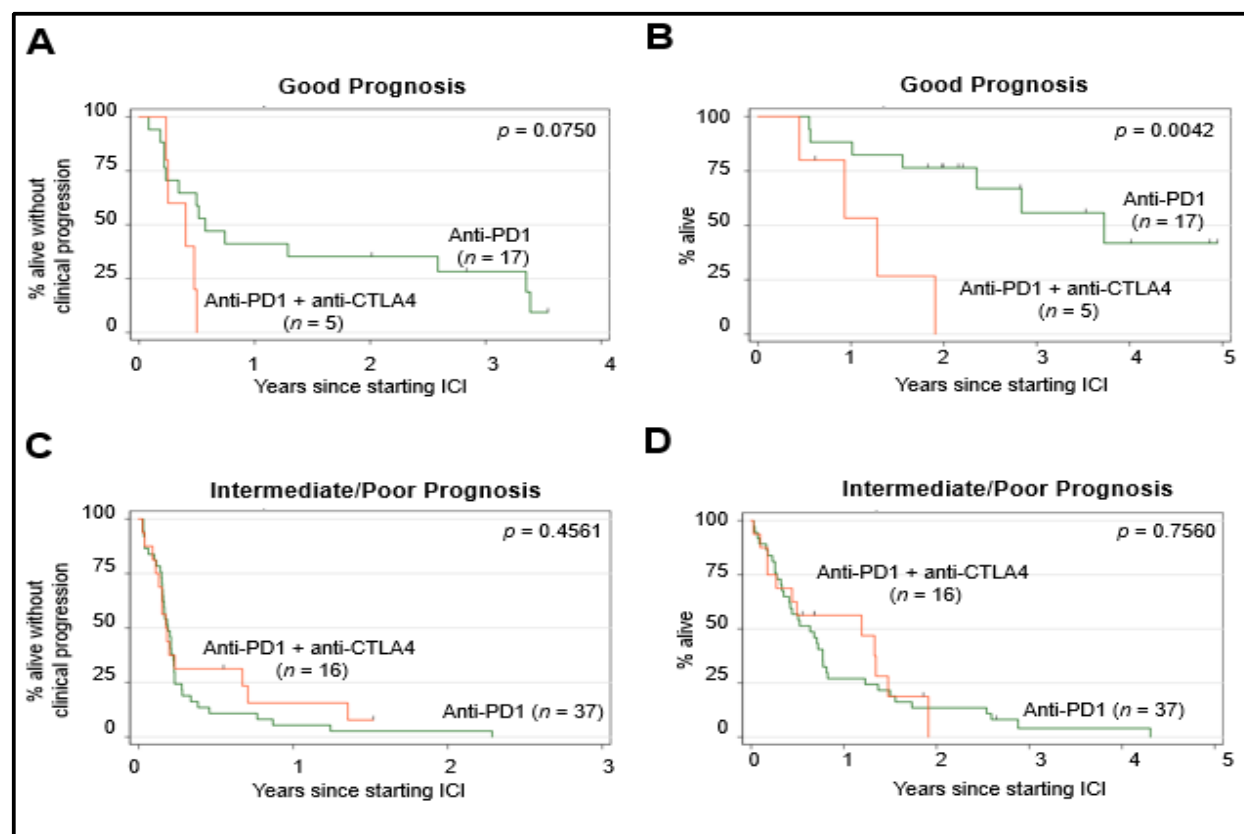
Figure 4. Survival according to MUMPS groups and ICI regimen. Survival outcomes of patients with good prognosis (MUMPS = 3) were stratified according to the anti-PD1/L1 regimen they received: anti-PD1/L1 monotherapy ( n = 17), anti-PD1 + anti-CTLA4 ( n = 5). cPFS is Scheme 0. (cPFS); p = 0.0042 (OS). Survival outcomes of patients with intermediate (MUMPS = 2) or poor prognosis (MUMPS = 0–1) were stratified according to the anti-PD1 regimen they received: anti- PD1/L1 monotherapy ( n = 37), anti-PD1 + anti-CTLA4 ( n = 16). cPFS is shown in ( A , C ) and OS is shown in ( B , D ). Log-rank test p = 0.4561 (cPFS); p = 0.7560 (OS).